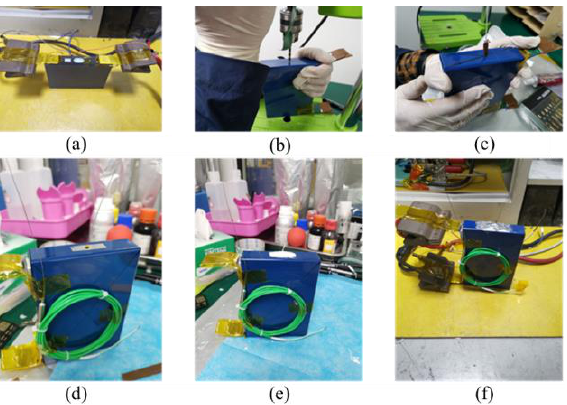
Figure 1. Process on thermocouple implantation. ( a ) Discharge; ( b ) drill the hole; ( c ) open access; ( d ) inserting the thermocouple; ( e ) gluing the thermocouple; ( f ) charge.